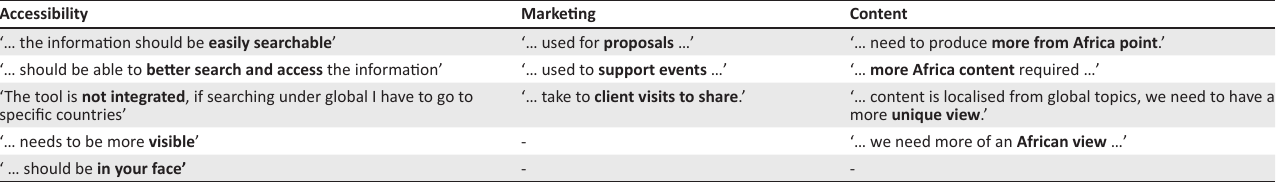
TABLE 4: Verbatim feedback from interviews for Eminence Tool (emphasis